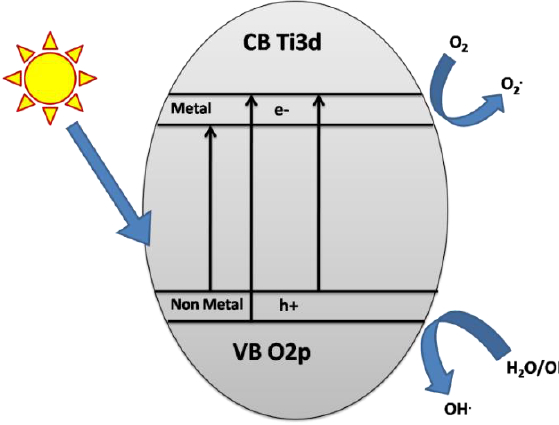
Figure 14. Schematic diagram for general photocatalysis mechanism for metal and nonmetal doped TiO 2 nanocomposite.